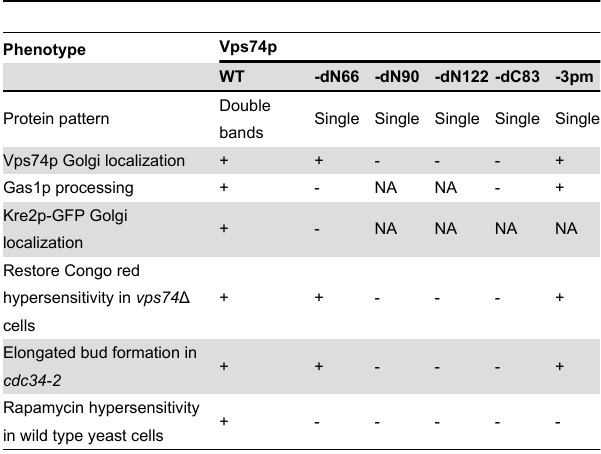
Table 1. Summary of the phenotypes of Vps74p and the mutant